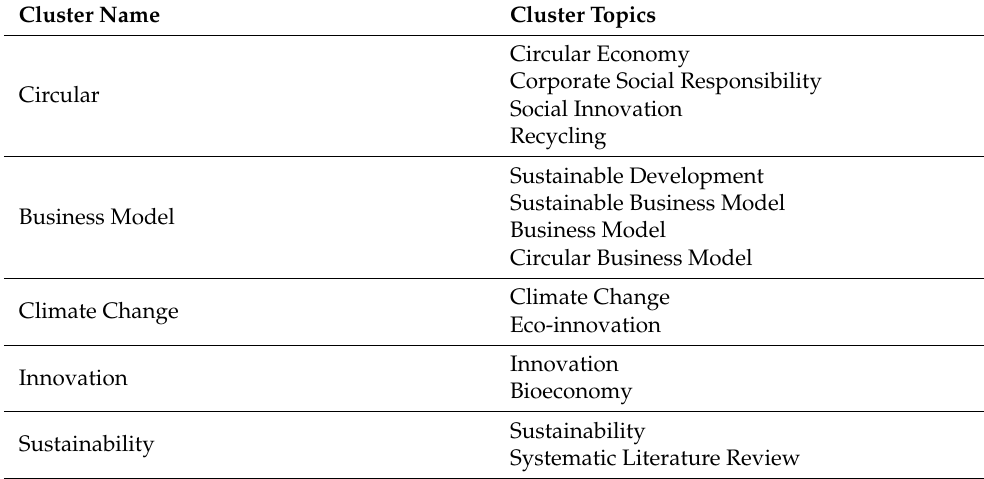
Table 5. Cluster themes of studies in the area of social innovation and